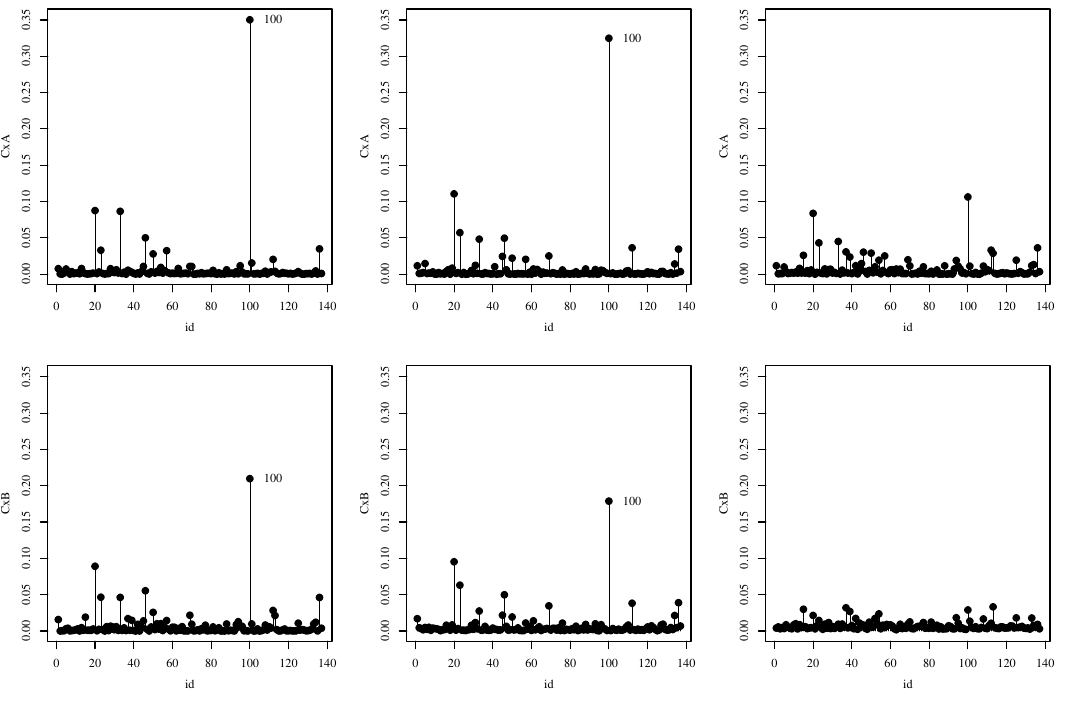
Figure A4. The index plots of C i for (cid:98) β ( upper ) and (cid:98) ν ( lower ) under the weight perturbation ( left ), response perturbation ( center ), and covariate perturbation ( right ) schemes for the RPGJSB2 q model with q = 0.9 (link loglog and G the cdf from the normal model) of the COVID-19 data